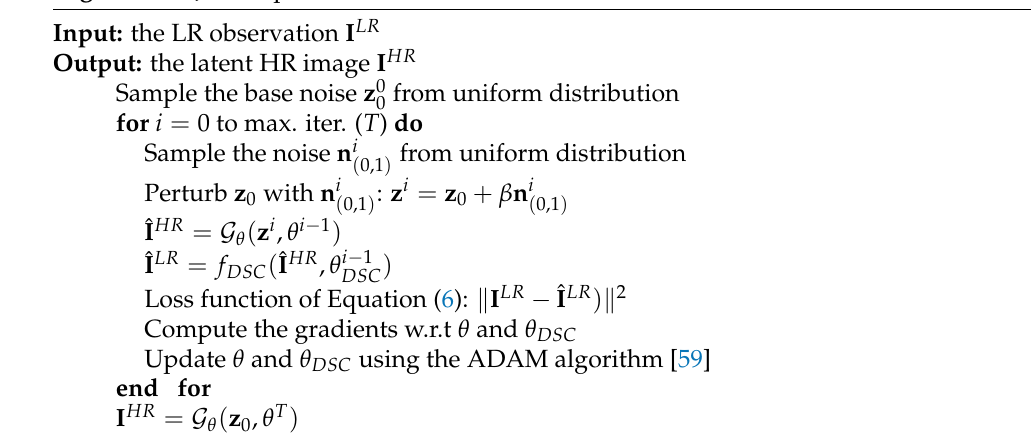
Algorithm 1 Joint Optimization for